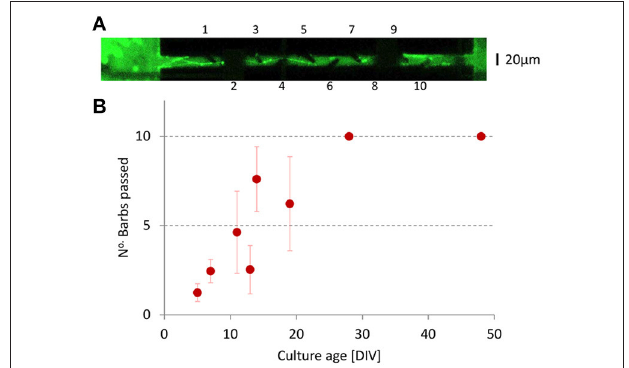
FIGURE 2 | Axon growth inside the channels. (A) Neurons and axons were stained with Cell Tracker Green to visualize the axons inside a channel. The image was slightly overexposed to better show the barbs. Protrusion was measured by the number of barbs that the axons passed (barb numbering indicated). In this example, the axon has passed the first five barbs. The channel electrodes obscured the view at two locations (dark areas around barbs 2 and 8). Near barb 10 some ingrowth in the opposite direction and some debris are visible. (B) The number of barbs passed in the foreseen direction (left to right) as a function of age. We never saw axons pass more than two barbs in the opposite